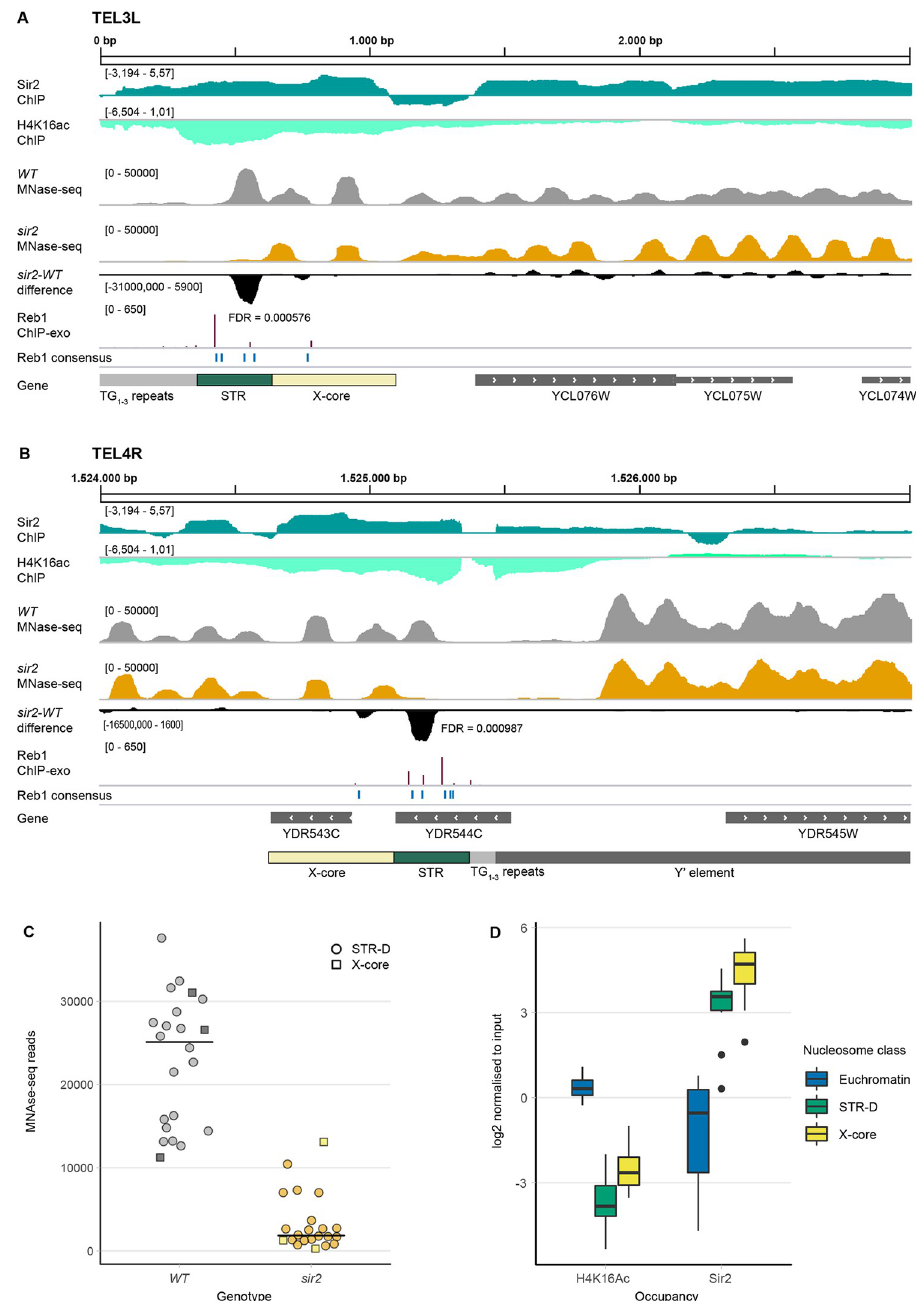
Fig 1. Chromatin features of WT and sir2 strains at the telomeres. ( A ) Illustration of 3000 bp from the left telomere of chromosome 3 in the Integrative Genome Viewer (IGV). Shown are tracks generated from ChIP-seq data for Sir2 (dark green) and H4K16 acetylation (light green), followed by MNase-seq tracks of WT (grey) and sir2 (orange) strains and the DANPOS-calculated difference between sir2 and WT (black). FDR value is given under/adjacent to the nucleosome with the largest difference. Reb1 consensus sites are denoted in blue and Reb1 occupancy levels (ChIP- exo) are shown in dark red. Genes are shown in the bottom track in grey. ( B ) Same as in ( A ), except showing a 3000 bp region from the right arm of chromosome 4. Note that YDR544C is a dubious ORF, unlikely to encode a protein. ( C ) MNase-seq read counts of the summit of the nucleosomes covering the STR-D (circles) or X-core loci (squares) of 22 telomeres in WT (grey) and sir2 (orange) strains. ( D ) Quantification of both acetylated H4K16 and Sir2 occupancy at the STR-D locus compared to the X-core region and euchromatin presented as box-plots. 15 STR-D loci were compared to 15 X-core loci and 24 randomly selected euchromatic